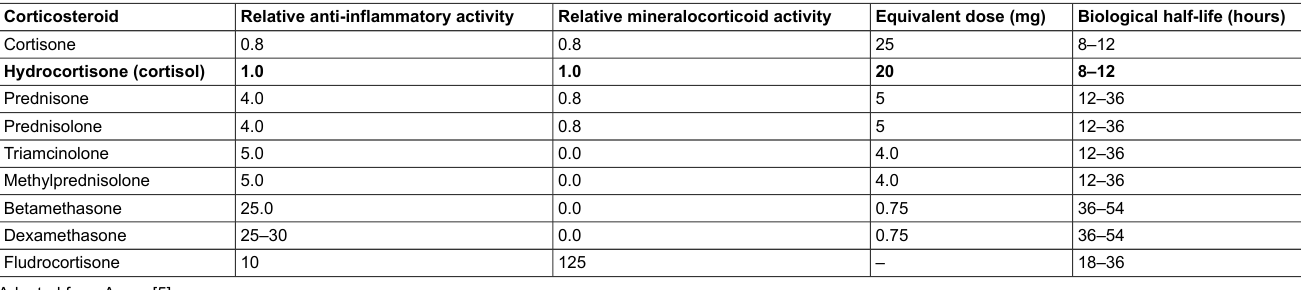
Table 1: Relative potencies and equivalent doses of common glucocorticoids.